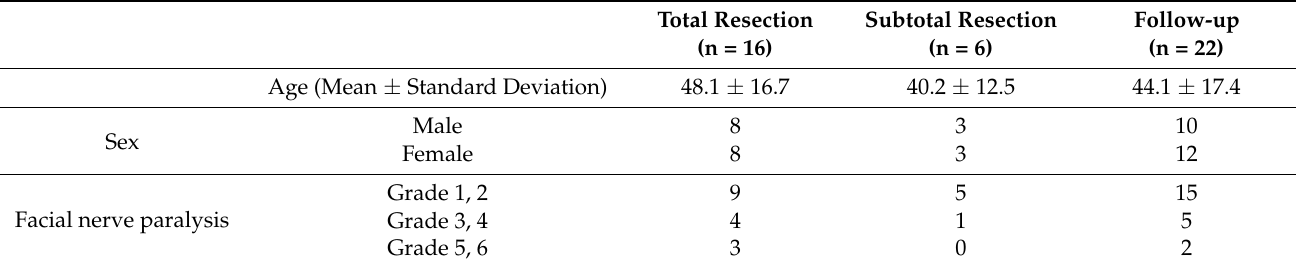
Table 1. Features of patients with each treatment policy.